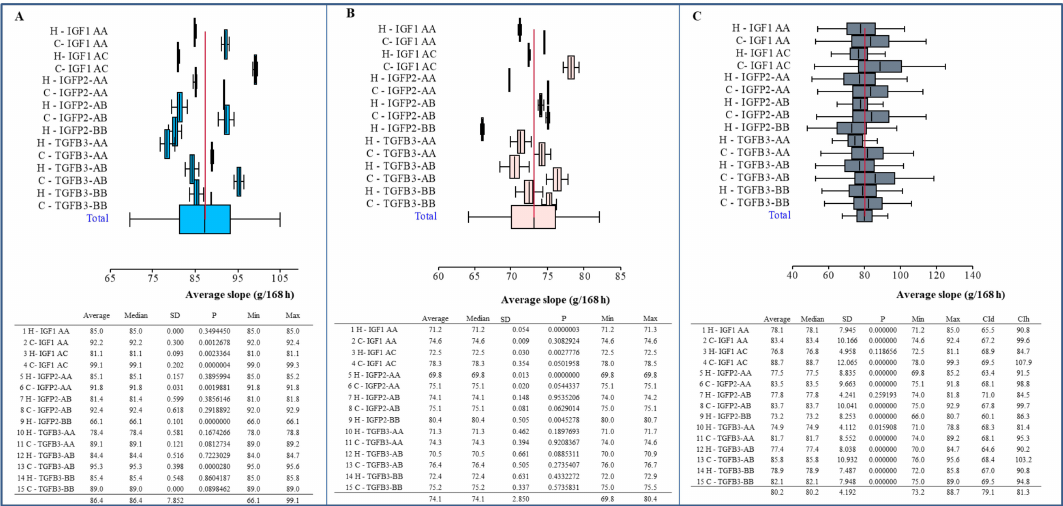
Figure 4. Forest plot of body weight (g) of chicken (at 14–42 days of age) of both lines in individual genotypes. ( A ) Males; ( B ) females; ( C ) total. Statistical characteristics of individual variants: average (n), median, standard deviation (SD), p -value (compared to average value), minimum (min) and maximum (max) value. Symbol H is Hubbard F15; C is Cobb E. The line segments represent confidence interval–CI